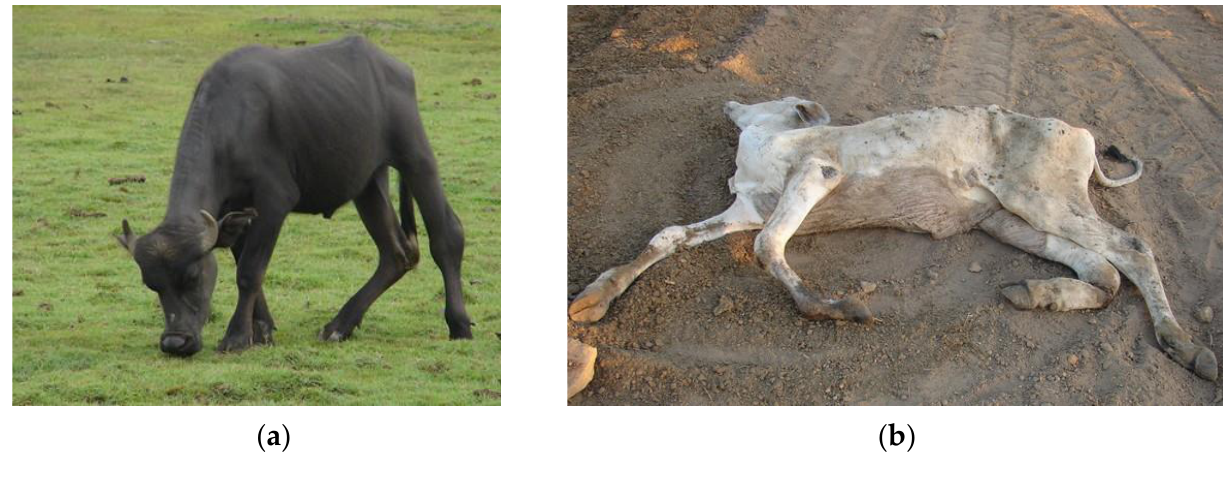
Figure 3. ( a ) Buffalo steer over 3 years old, underdeveloped, with postural deviations and thickened tarsal articulation (hock joint) [11]. ( b ) Nellore steer with a metatarsal fracture that occurred while unloading the truck [11].